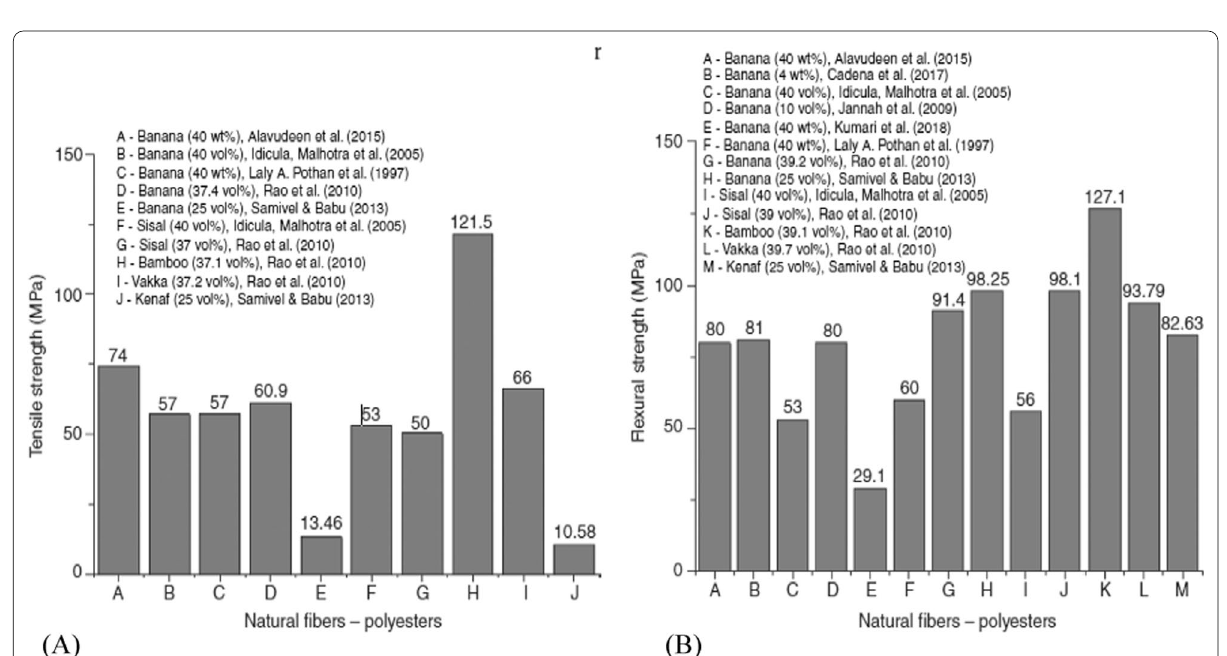
Fig. 5 Tensile ( a ) and flexural ( b ) strength of natural fibre-reinforced polyester composites (Kulkarni et al. 2019)